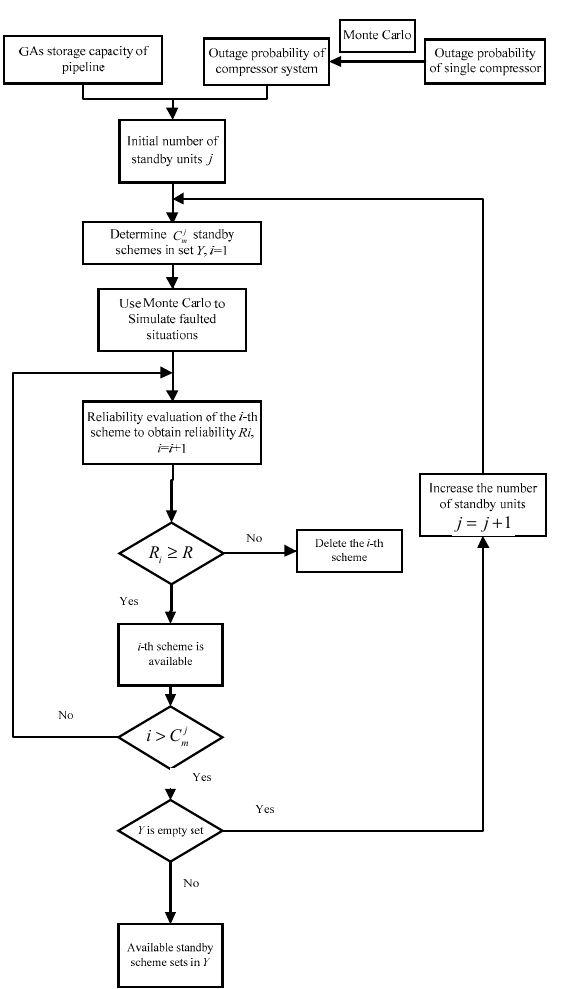
Figure 2. Program steps for the standby scheme.